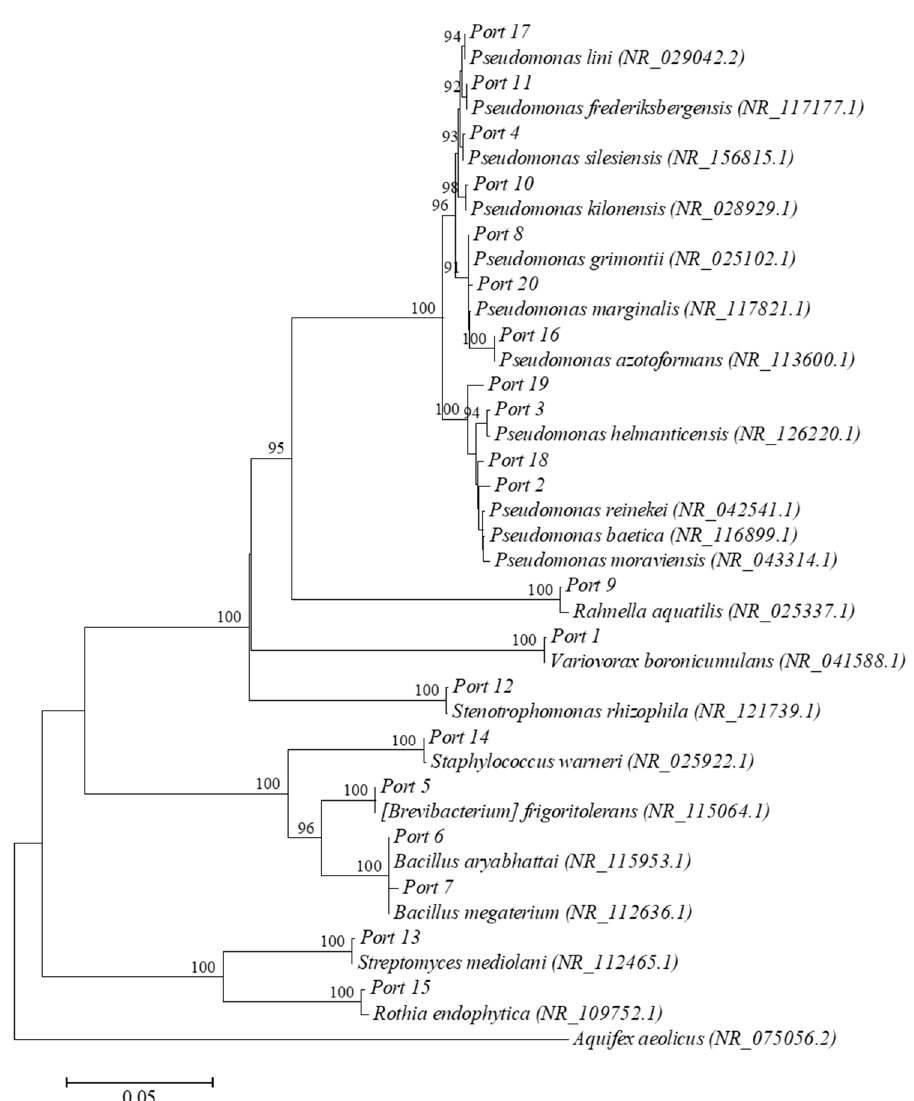
Figure 4. Phylogenetic tree of phosphate-solubilizing bacteria isolated from the rhizosphere soil of Portulaca oleracea L. and their closest relatives registered in GenBank (NCBI).